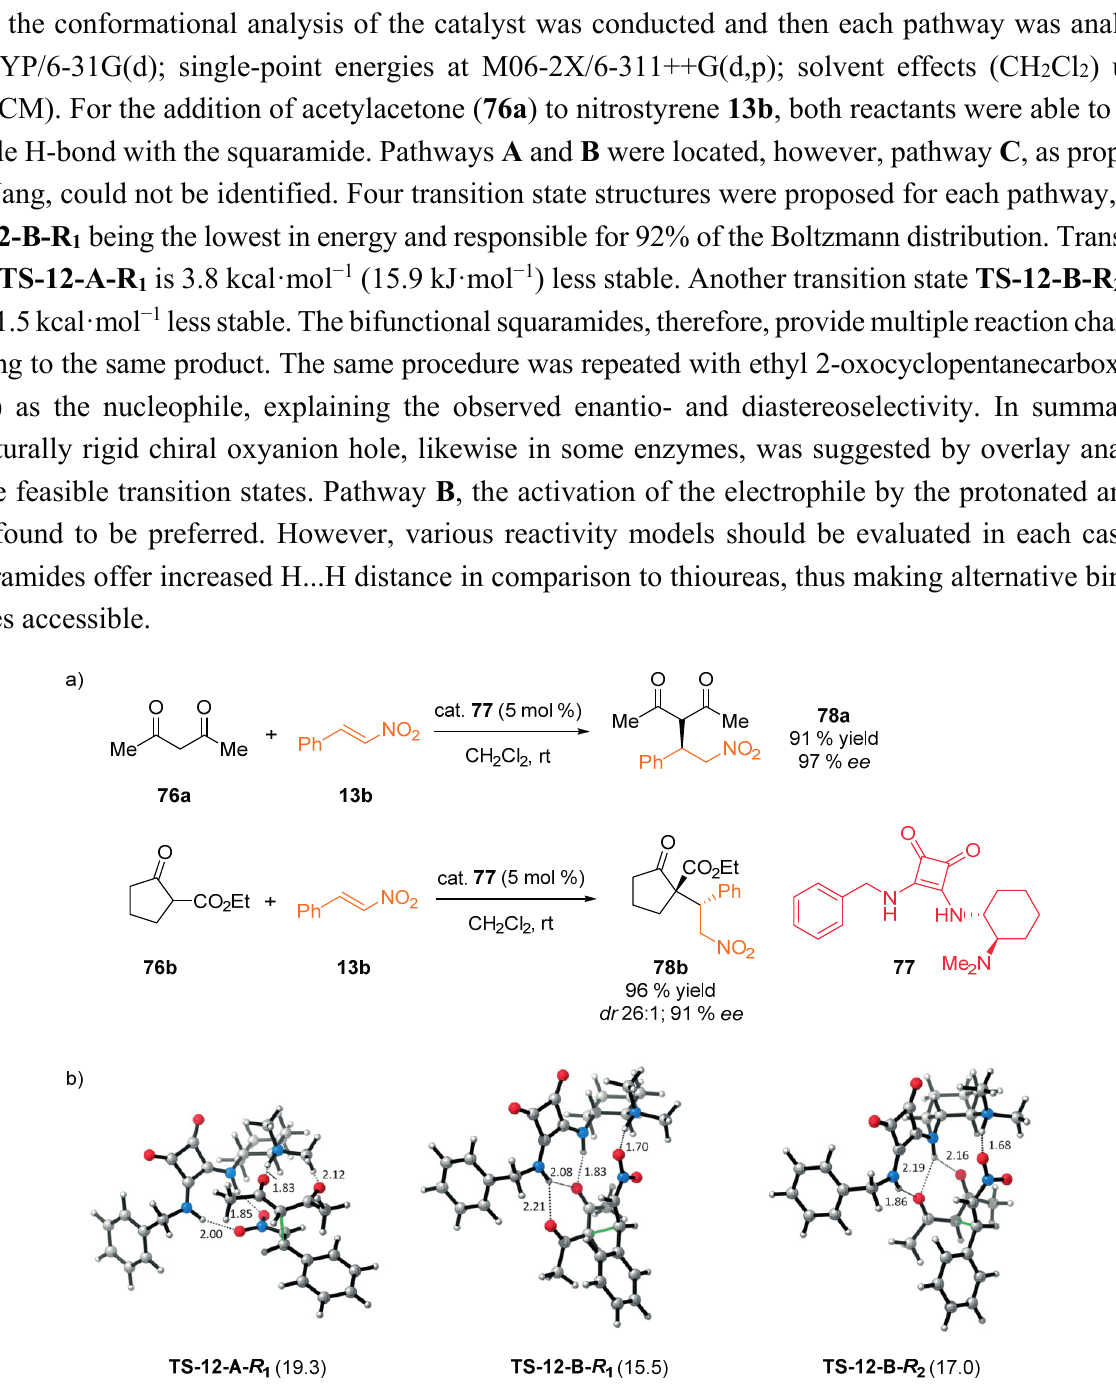
Figure 19. Michael reaction of acetylacetone ( 76a ) and 76b to nitrostyrene ( 13b ) ( a ); selected calculated transition states for pathways A and B leading to 78a ( b ). Adapted with permission from Ref. [51]. Copyright (2014) John Wiley and